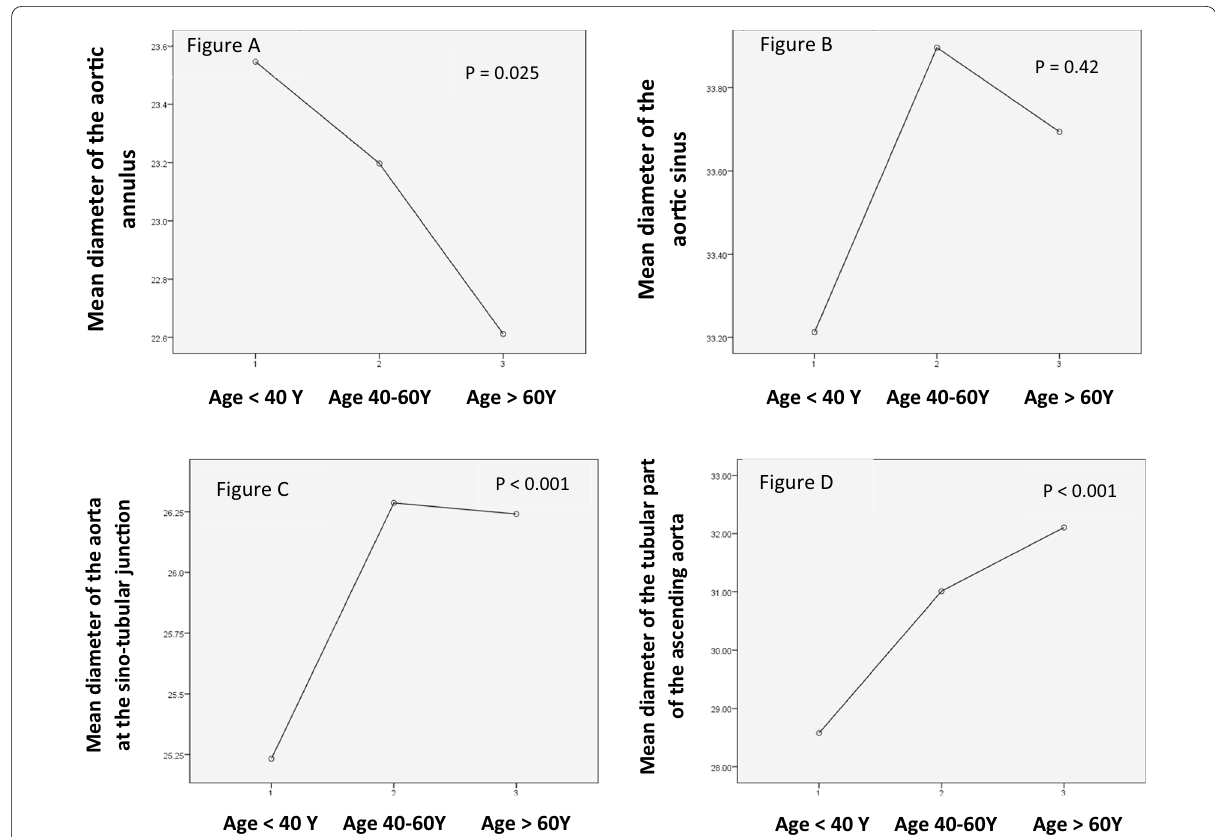
Fig. 5 a Mean diameter of the aortic annulus in the age groups (< 40 Y, 40–60 Y and > 60 Y), b mean diameter of the aortic sinus in the age groups (< 40 Y, 40–60 Y and > 60 Y), c mean diameter of the aortic sino‑tubular junction in the age groups (< 40 Y, 40–60 Y and > 60 Y), d mean diameter of the tubular part of the ascending aorta in the age groups (< 40 Y, 40–60 Y and > 60 Y)